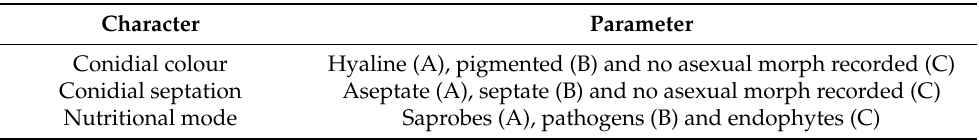
Table 2. Parameters of each character used in ancestral state